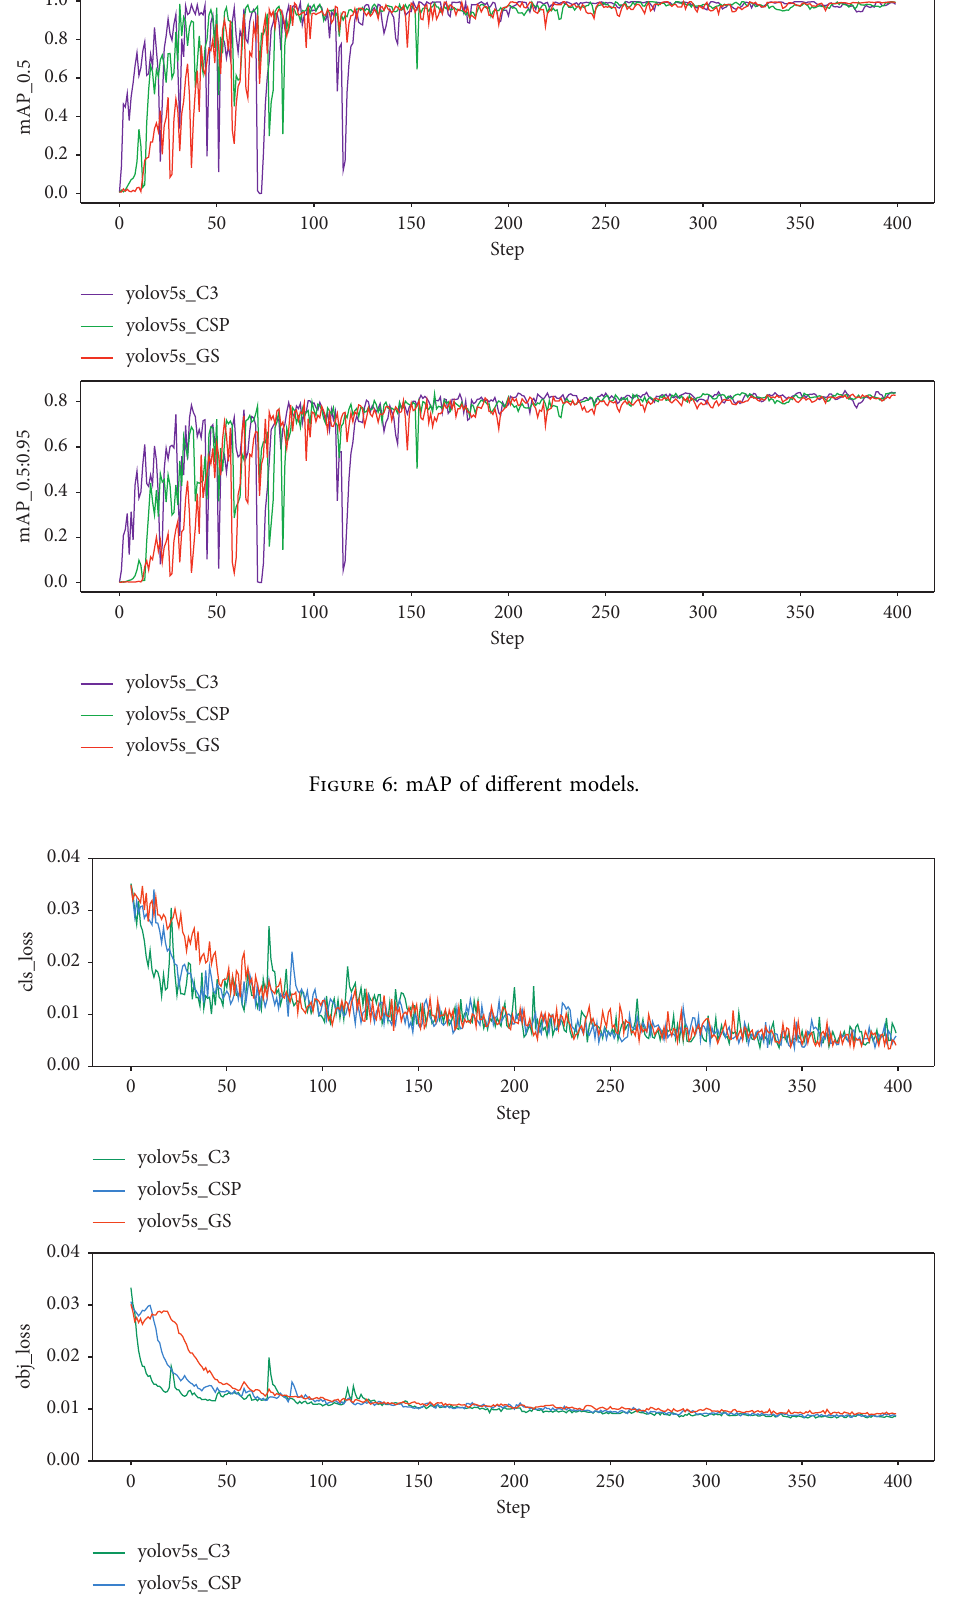
Figure 7: Loss of different